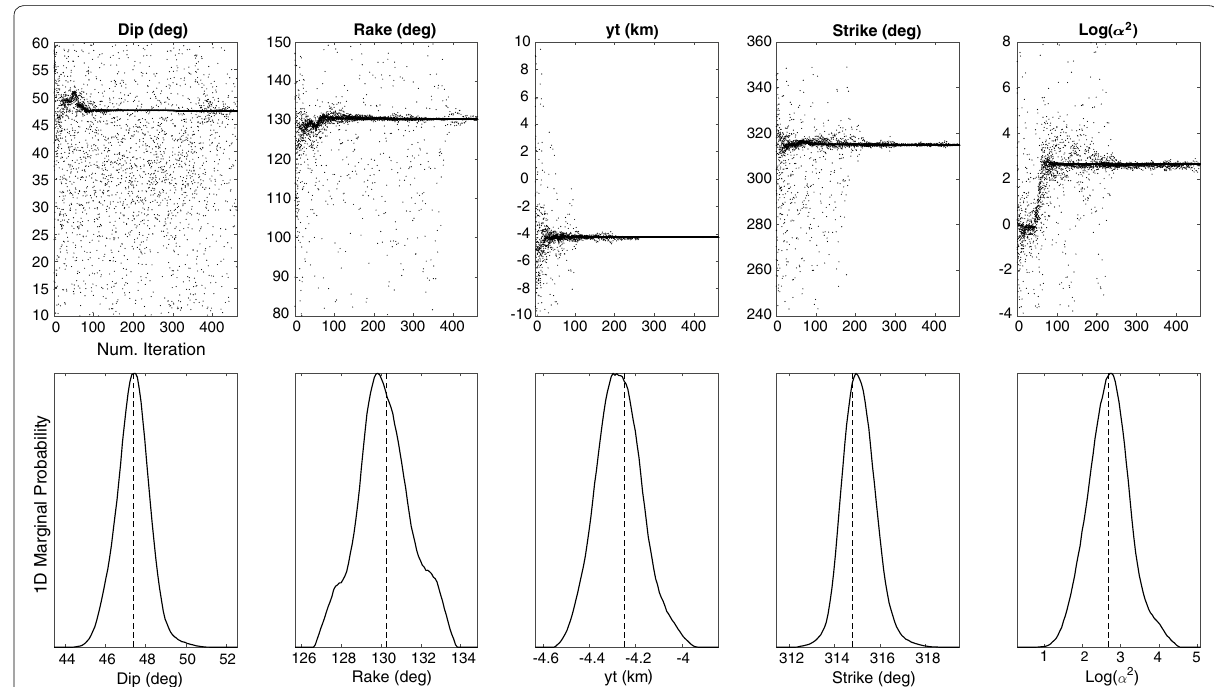
Fig. 5 (Top) Number of iterations versus the values of nonlinear parameters. (Bottom) One-dimensional marginal probability density functions for the nonlinear parameter. Dashed lines correspond to the maximum likelihood values. The parameter yt is the location of the mid-point of the fault top side along the northing axis. The parameter Log( α 2 ) is the weight of the smoothing